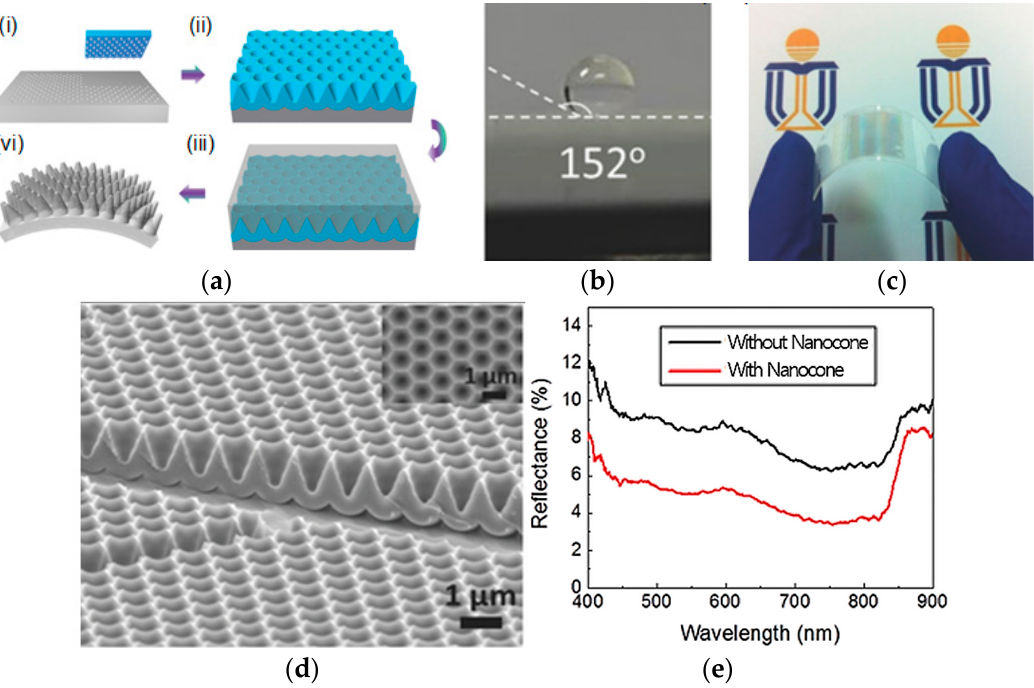
Figure 3. ( a ) Schematics of a nanocone film of an Au-coated template and PDMS nanocones: ( i ) A Si mold with hexagonally-ordered nanopillars was used as an imprint mold with four nanoimprint steps; ( ii ) An I-cone array fabricated by a multi-step anodization and wet etching process on the imprinted Al foil; ( iii ) Premixed PDMS poured on an Au-coated template followed by a degassing and curing process; ( iv ) Regular nanocones on flexible PDMS after peeling-off. ( b ) A drop of water on the nanocone PDMS film, showing a large contact angle of 152°; ( c ) Flexible nanocone film; ( d ) A SEM image of a Au-coated template with a 1-µm depth; ( e ) A reflectance measurement of a CdTe device with and without the nanocone structure. Reproduced from [65] with permission; Copyright Wiley 2014.